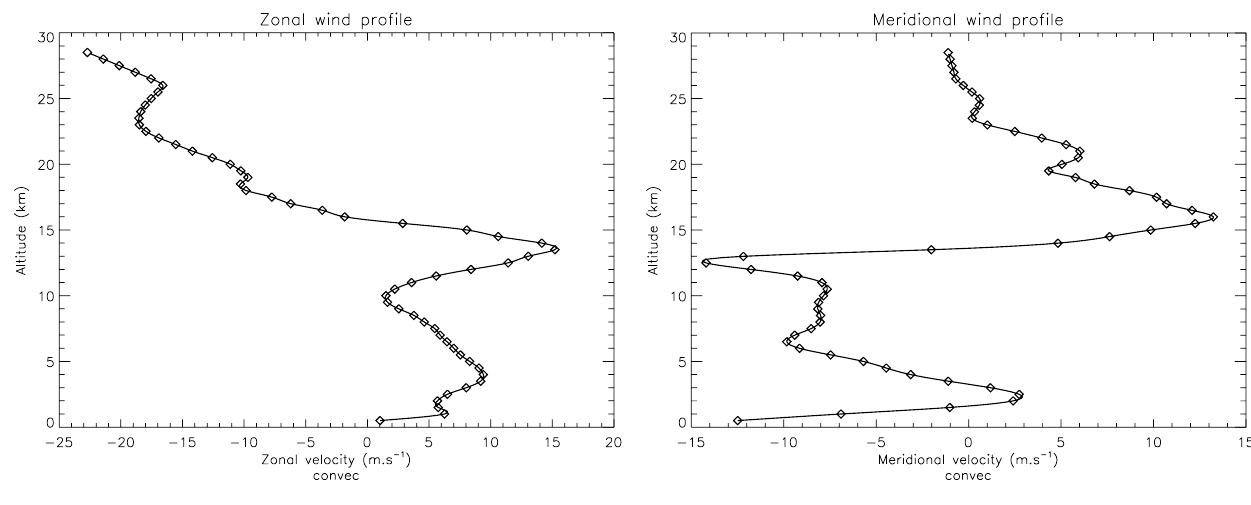
Fig. 15. Case 2: Results of the WRF simulations. Vertical profile of the wind velocity (ms − 1 ). Diamonds correspond to WRF vertical data points. Full line is a cubic spline interpolation with vertical resolution of 100m. Left: Zonal wind profile. Right: Meridional wind